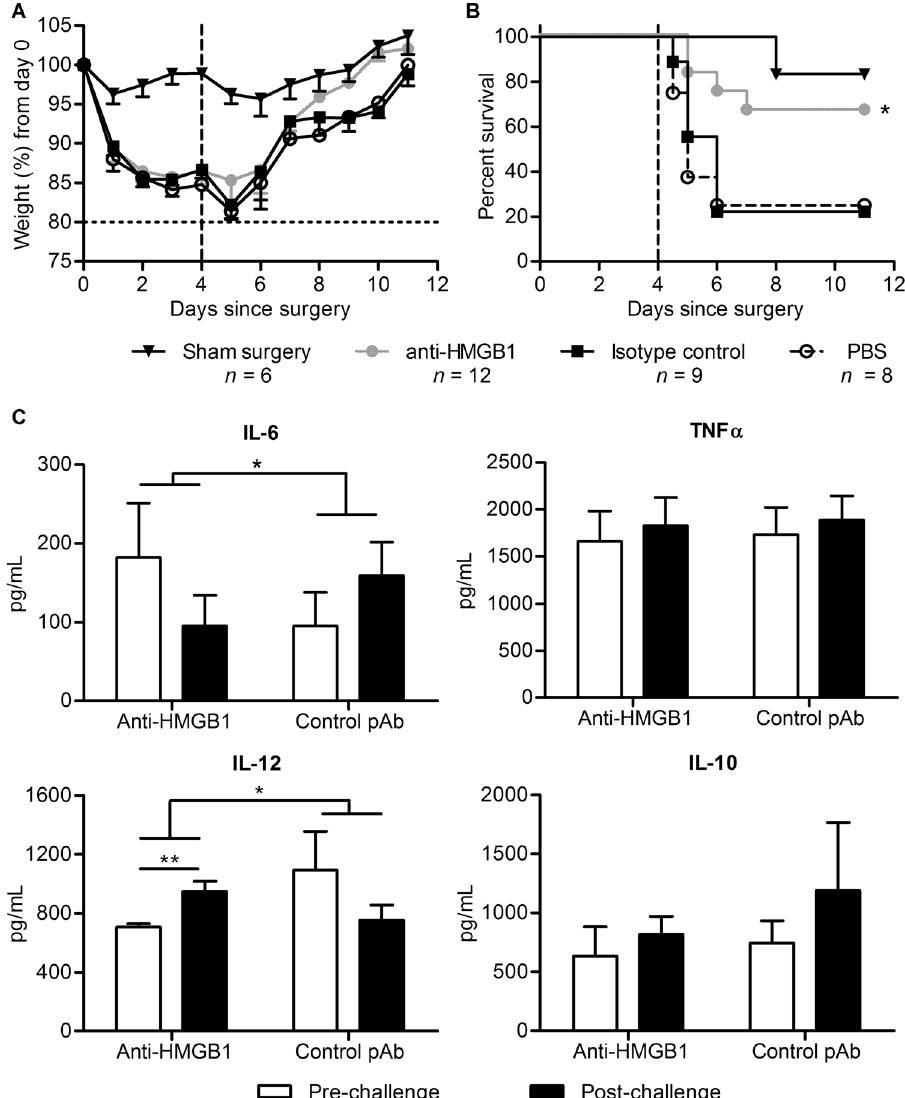
Figure 6. Prior anti-HMGB1 pAb treatment alters the inflammatory response and survival to secondary bacterial challenge in mice that have survived CLP-induced sepsis. Mice (n = 6–12) were subjected to sham- surgery or mild CLP and allowed to recover before IN instillation of P . aeruginosa (2.5 × 10 7 CFU) or PBS on Day 4 (indicated by dashed line). Mice were treated 8 hours following surgery with anti-HMGB1 or control pAbs (20 mg/kg) or PBS and administered maintenance pAb doses (10 mg/kg) or PBS on days 3 and 6. Mice were monitored for disease symptoms and euthanised at predetermined humane endpoints. Mean - SEM weight loss ( A ; humane weight loss endpoint indicated by horizontal dashed line) and survival ( B ) and of mice are depicted. Serum samples collected from mice ( n = 4–5) immediately prior to bacterial challenge and 24 hours after challenge were analysed for IL-6, IL-10, IL-12 or TNF α content via ELISA ( C ). Survival curves were compared via Mantel-Cox analysis, and changes in cytokines before and after treatment were compared via paired t-test. Cytokine changes between groups were compared via two-way matched pairs ANOVA, with significance denoted as thus: * P < 0.05, ** P <